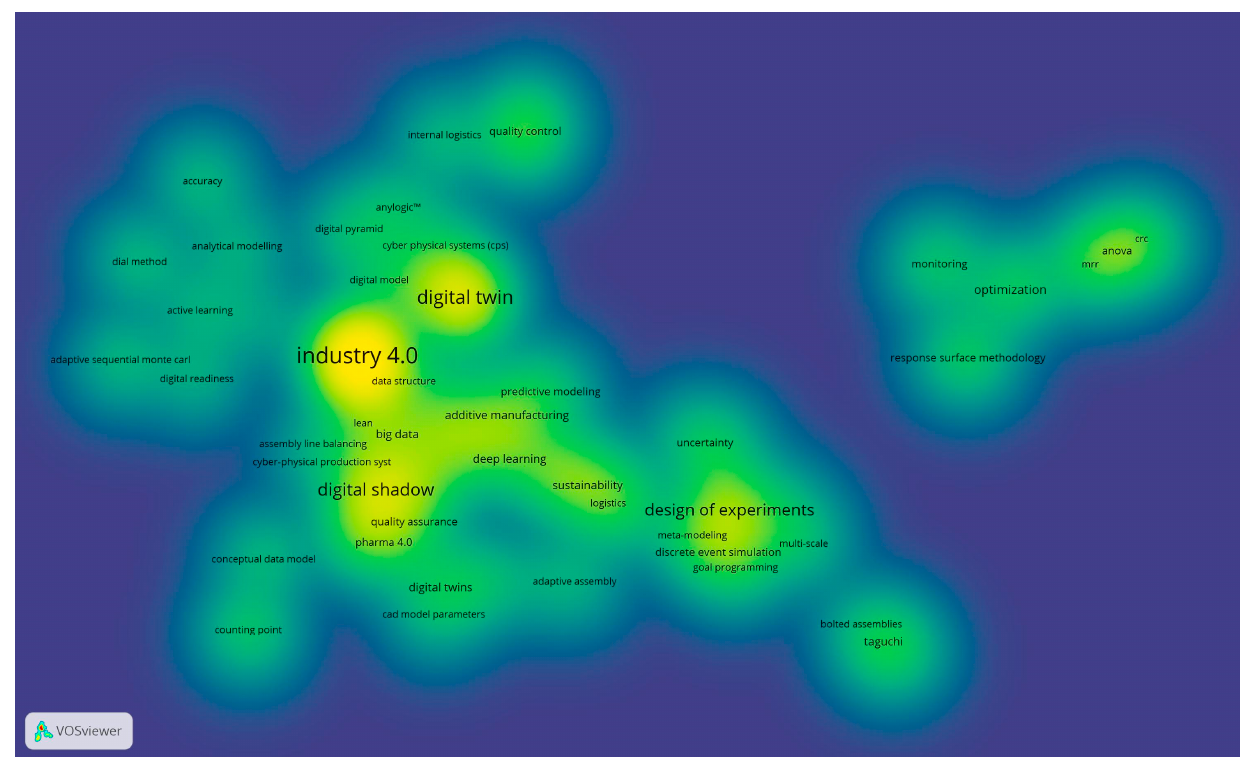
Figure 2. Density Visualization of the Scientific Literacy Topic Areas.